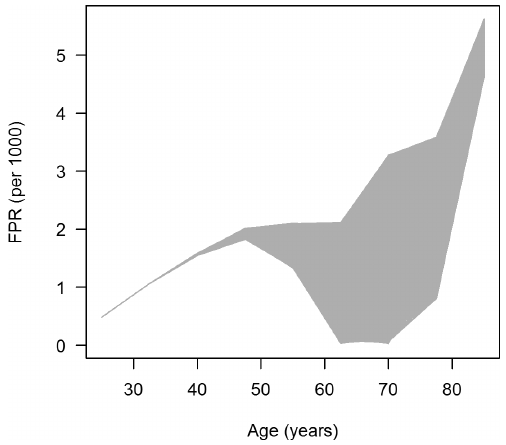
Figure 4. Age-specific false-positive ratios (FPR) inthe simulated sensitivity scenarios. Eachdot in the grey area represents the FPR generated by one of the scenarios about the age-specific